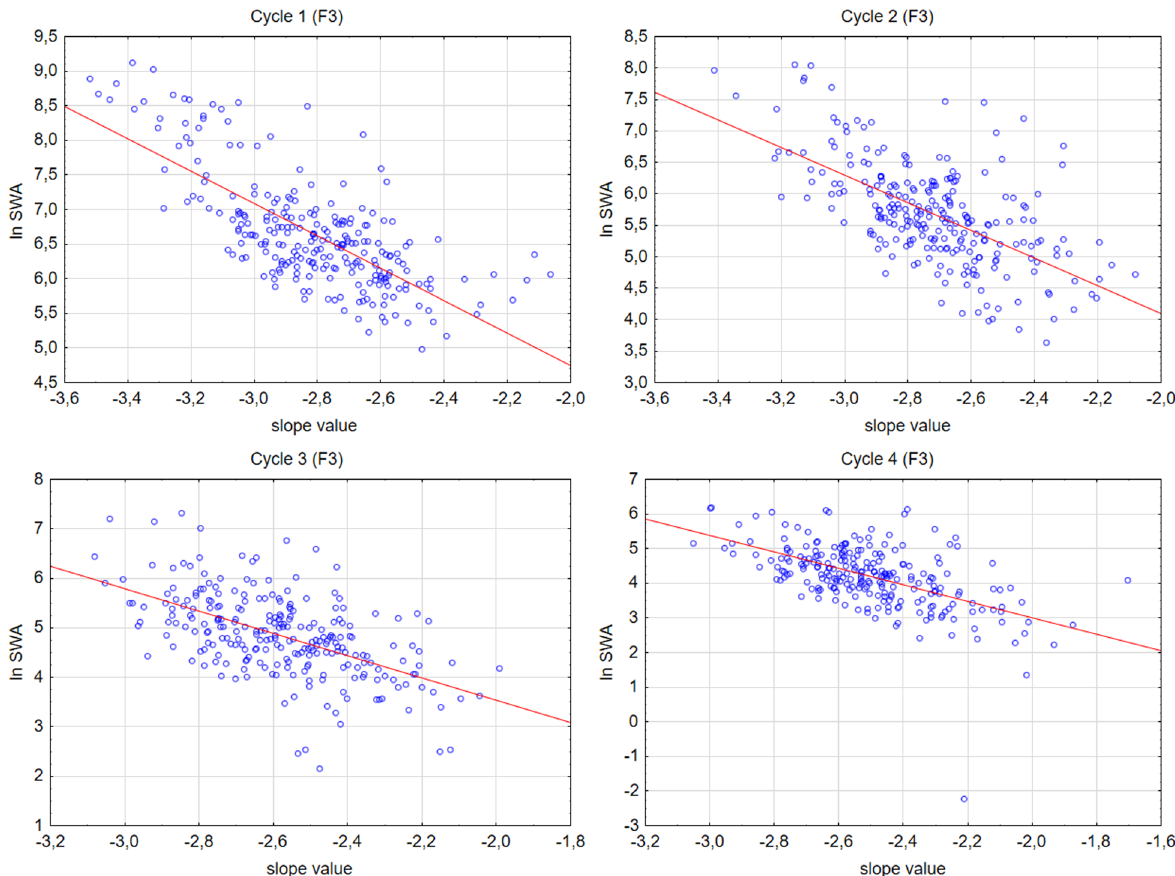
Figure 4. Scatterplots of the correlations between spectral slope value and lnSWA at the left frontal EEG location